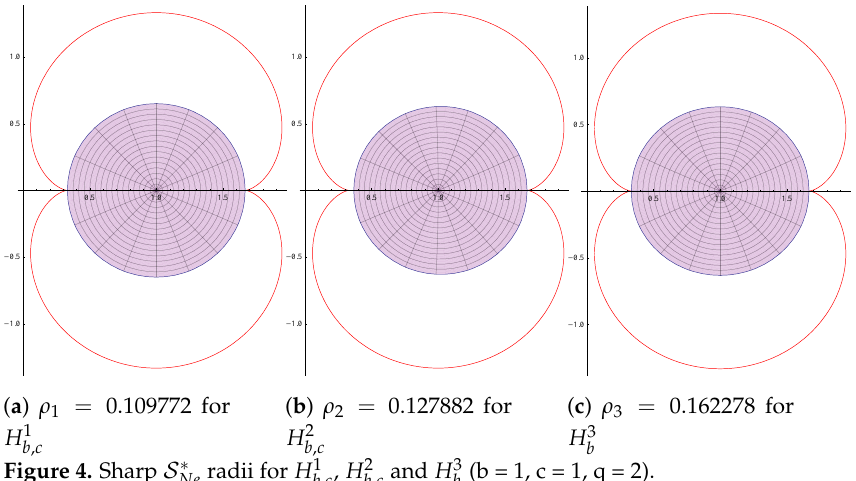
radii for H 1 Ne